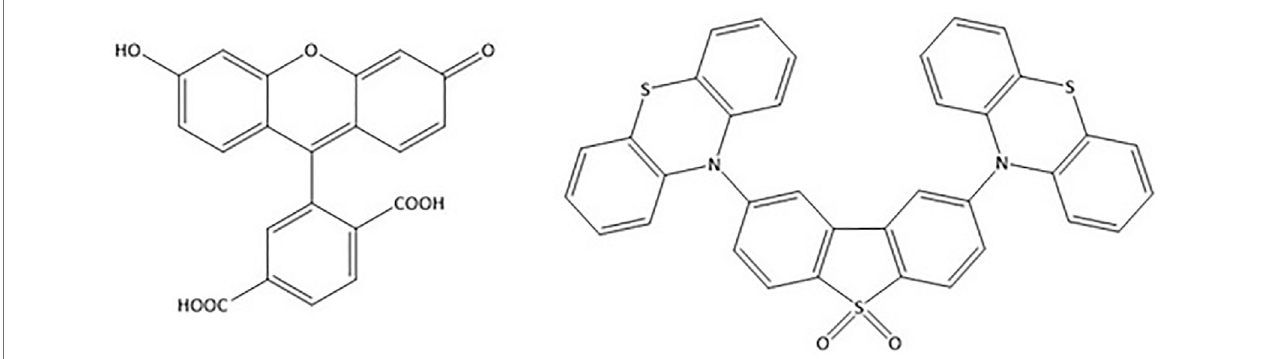
FIGURE 1 | Chemical structure of molecular systems and complexes used in this work. 5 (6)-Carboxy fl uorescein (left) and the TADF complex (2,8-di (10H- phenothiazin-10-yl)dibenzo [b,d]thiophene 5,5-dioxide) (DPTZ-DBTO2) (right) in their skeletal formula. See text for details.